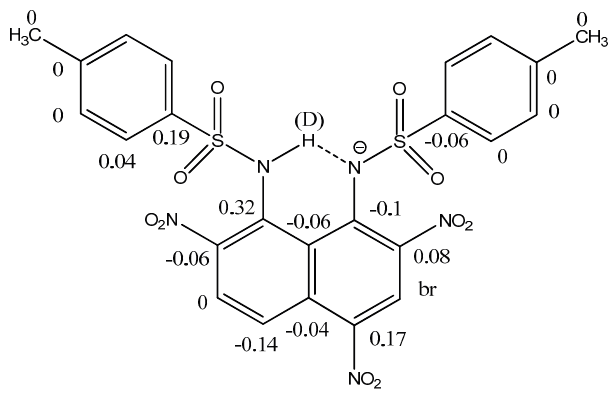
Figure 13. Deuterium isotope effects on 13 C chemical shifts in